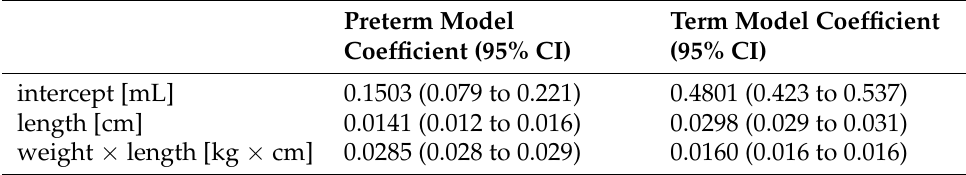
Table 1. Coefficients of linear regression model of stroke